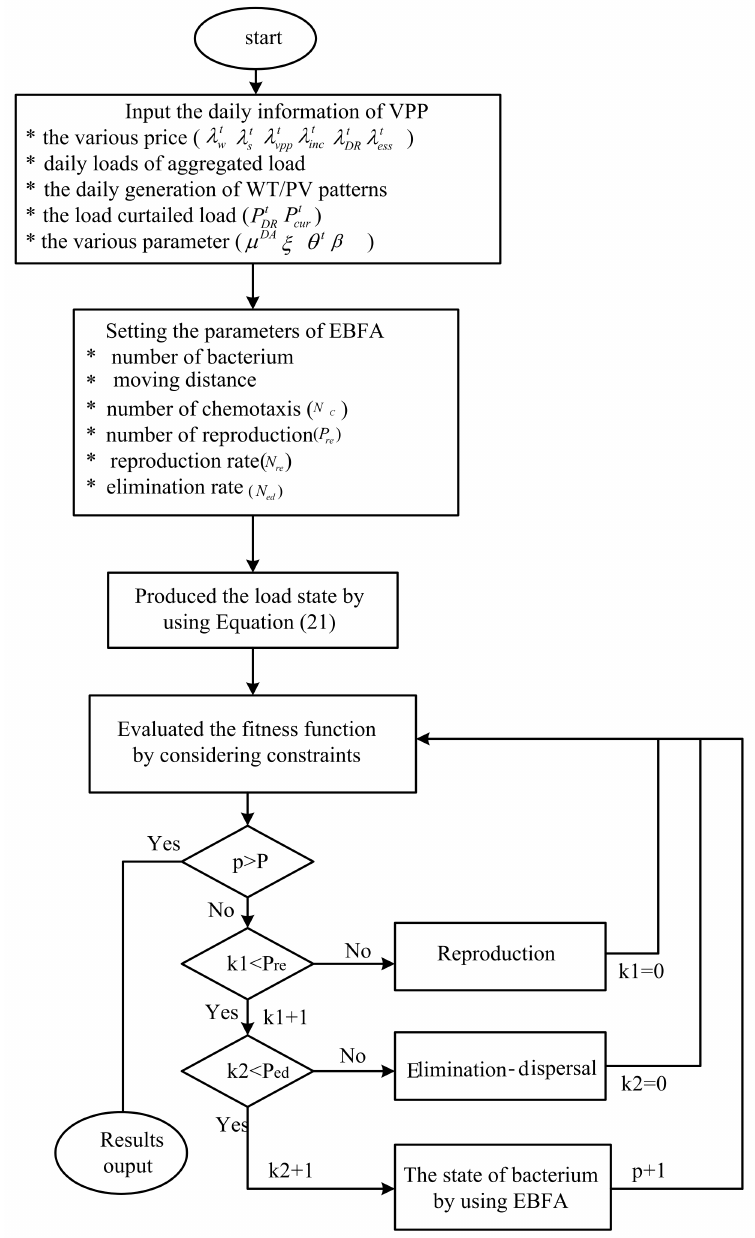
Figure 4. The flowchart of applied